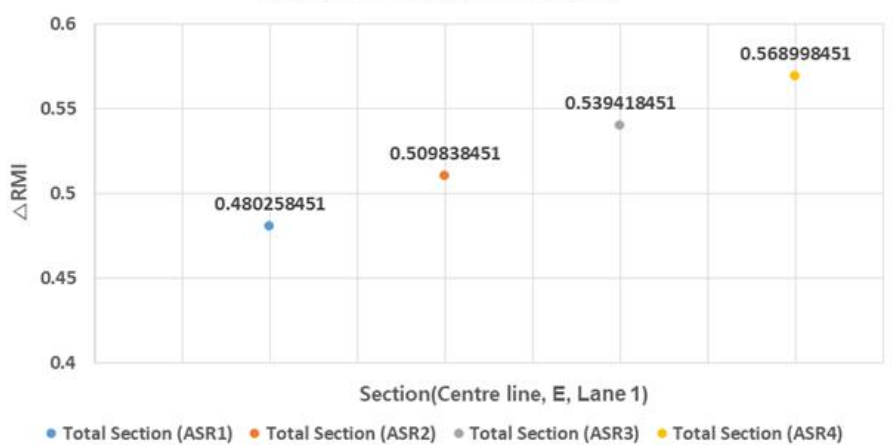
Figure 6. Total section– ∆ RMI relationship (ASR grade 1–4).